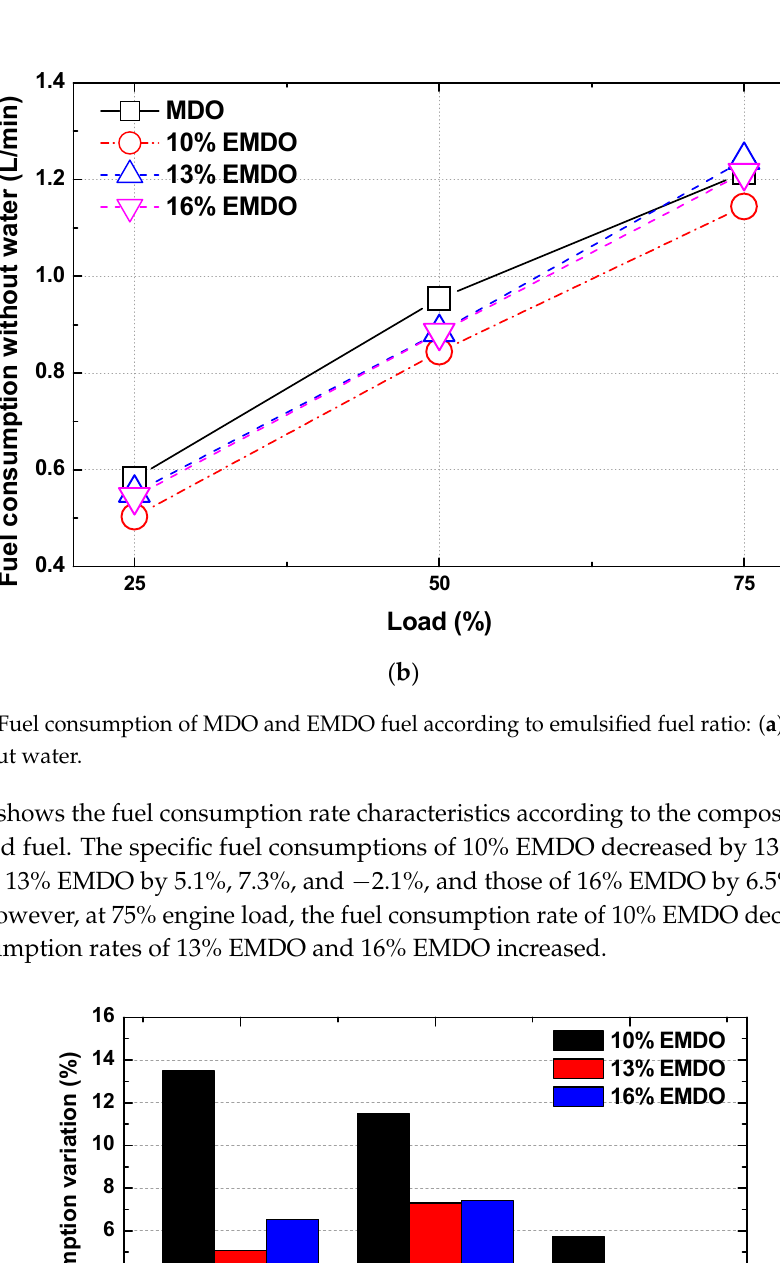
Figure 9. Fuel consumption without water with MDO and EMDO according to emulsified fuel ratio.